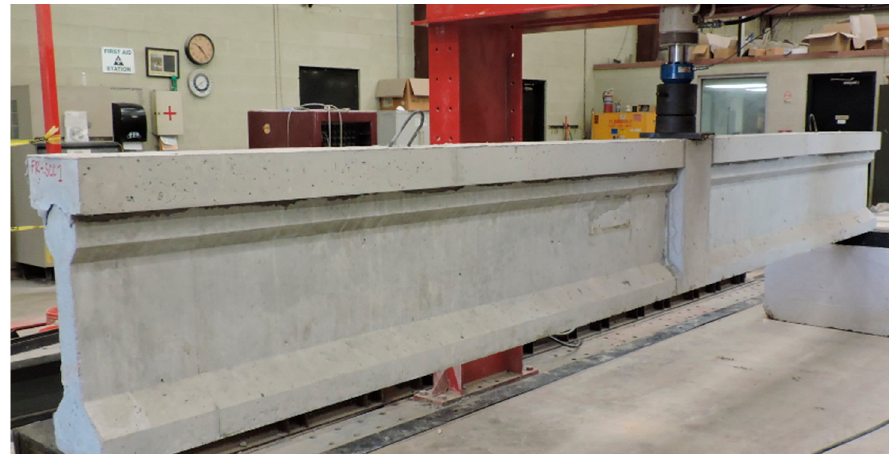
Figure 4. Initial crack test